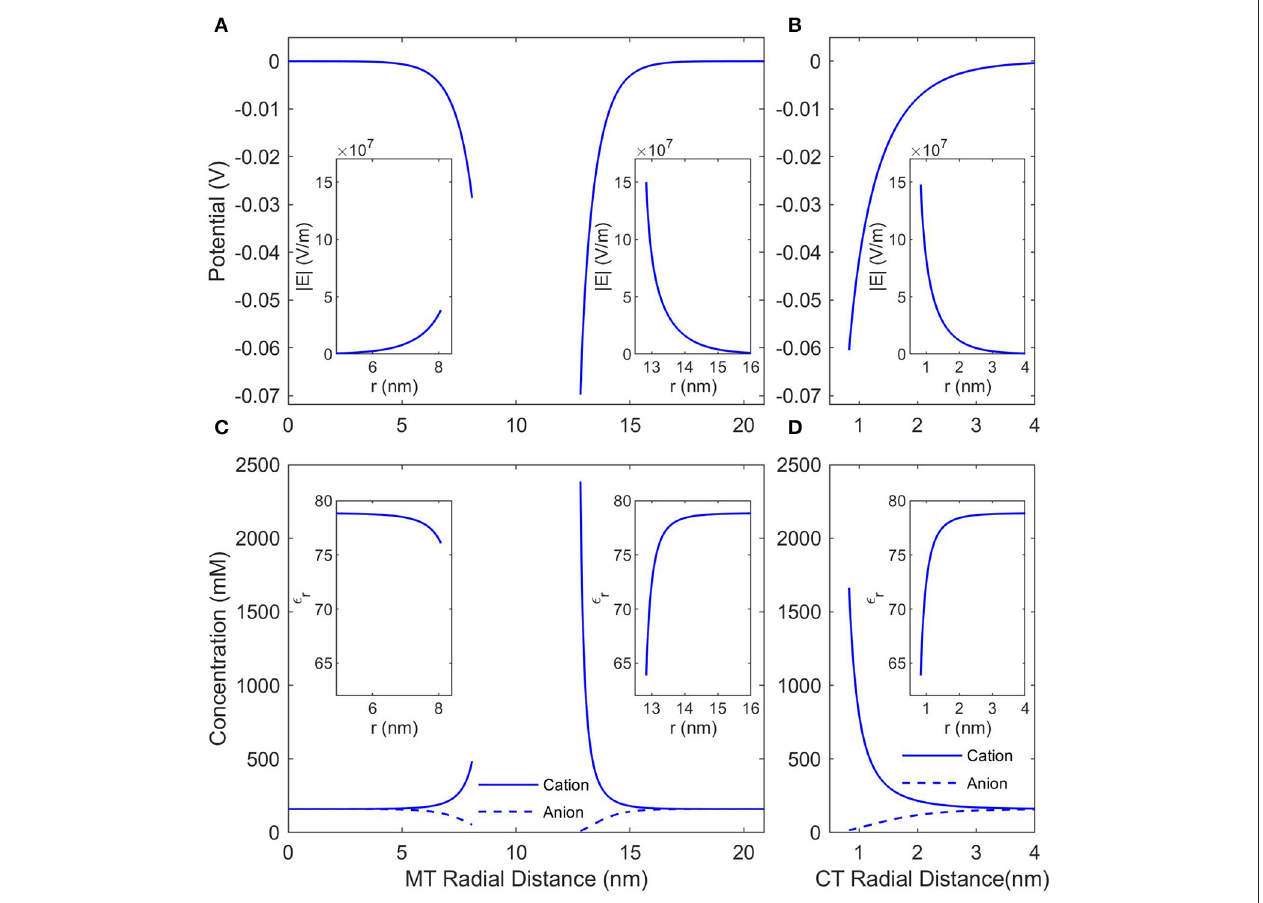
FIGURE 2 | The counterionic concentrations and electrostatic potentials surrounding a microtubule when the buffer ionic concentration is 160 mM KCl. (A) Shows the potential profile near the inner and outer surfaces of an SMT; the radial distance is measured from the center of the microtubule, and the insets show the electric field strength as a function of the same radial distance. (B) Shows the potential profile near a single, isolated CT; the radial distance is measured from the center of the CT, and the inset shows the electric field strength as a function of the same radial distance. (C,D) Show the concentrations of anions and cations and the insets show the relative permittivity. The radial distances in (C,D) are the same as in (A,B) , respectively.